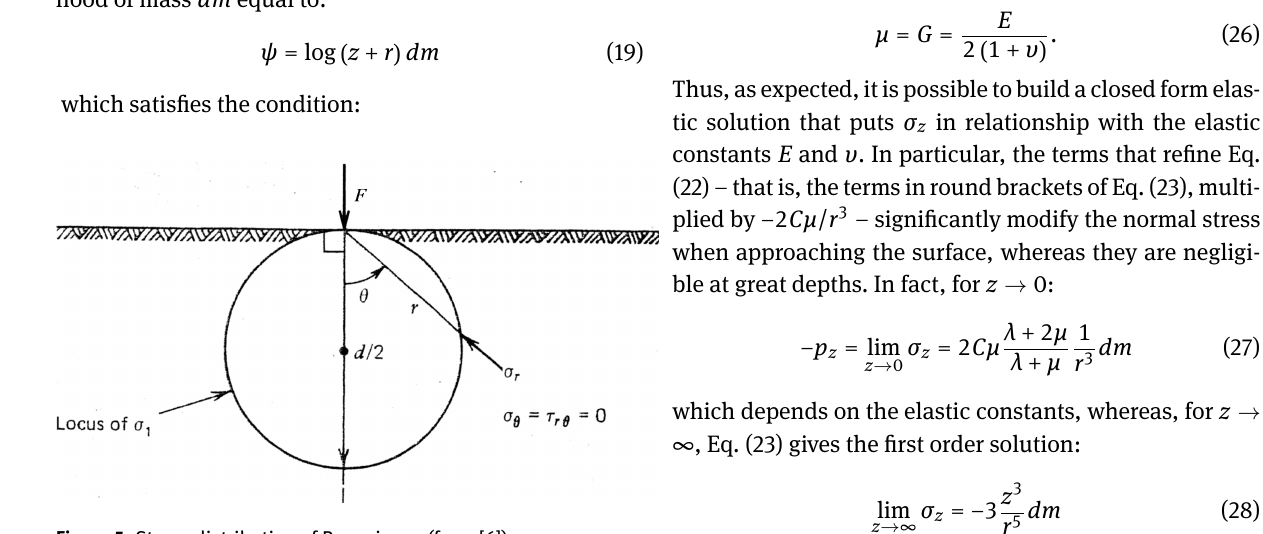
Figure 5: Stress distribution of Boussinesq (from